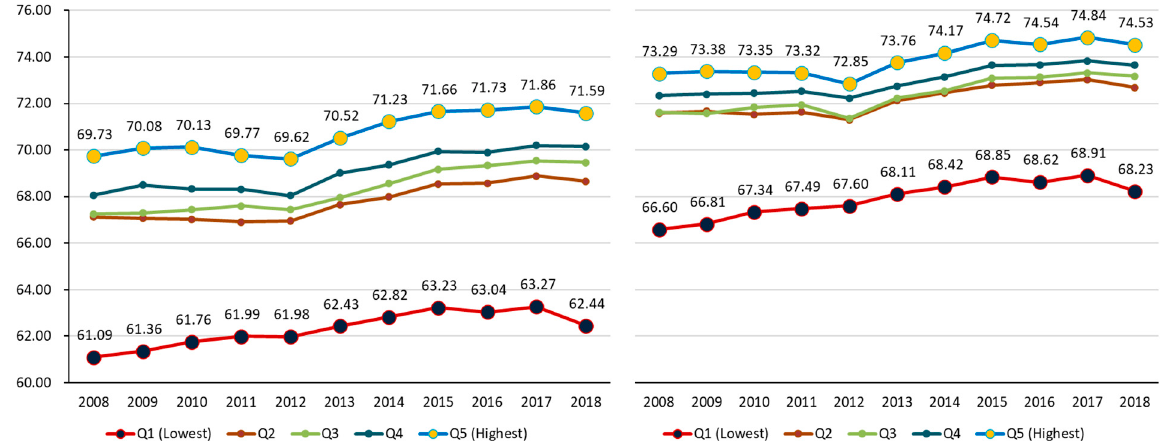
Figure 1. The HALE by income level for males and females in Korea (2008–2018) (unit: years).